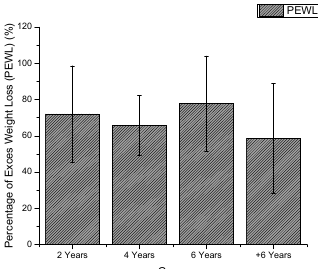
Figure 2. Percentage of excess weight loss (PEWL) in the different groups.